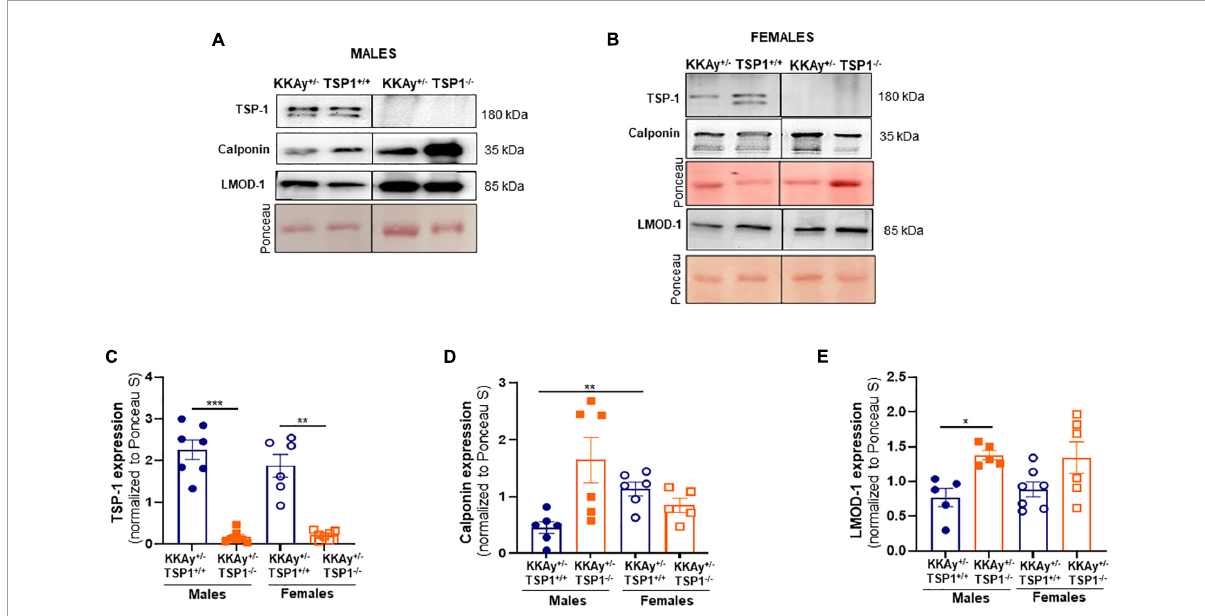
FIGURE7 TSP-1 deletion increases LMOD-1 and calponin expression in aortic vessels of male MetS KKAy + / − mice. Shown are representative western blots for TSP-1, LMOD-1 and calponin expression in aortic lysates derived from (A) male KKAy + / − TSP-1 + / + and KKAy + / − TSP-1 − / − mice and (B) female KKAy + / − TSP-1 + / + and KKAy + / − TSP-1 − / − mice. Shown are summary graphs for densitometric quantification of immunoblots for (C) TSP-1, (D) Calponin, and (E) LMOD-1 expression. n = 5–7 animals per genotype per sex. All results are expressed as mean ± SEM. * p < 0.05, *** p < 0.0005. Loading control = Ponceau S. Data shown illustrates protein expression normalized to Ponceau S. For representative immunoblots, lane images depict proteins loaded and detected on a single immunoblot (full blots shown in Supplementary Figures 3, 4 ); however, lanes were re-arranged to improve the clarity of presentation.